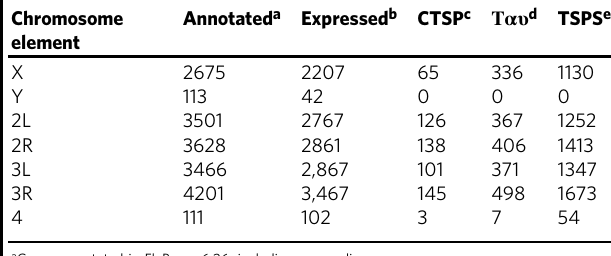
Table 1 Chromosome element genes and